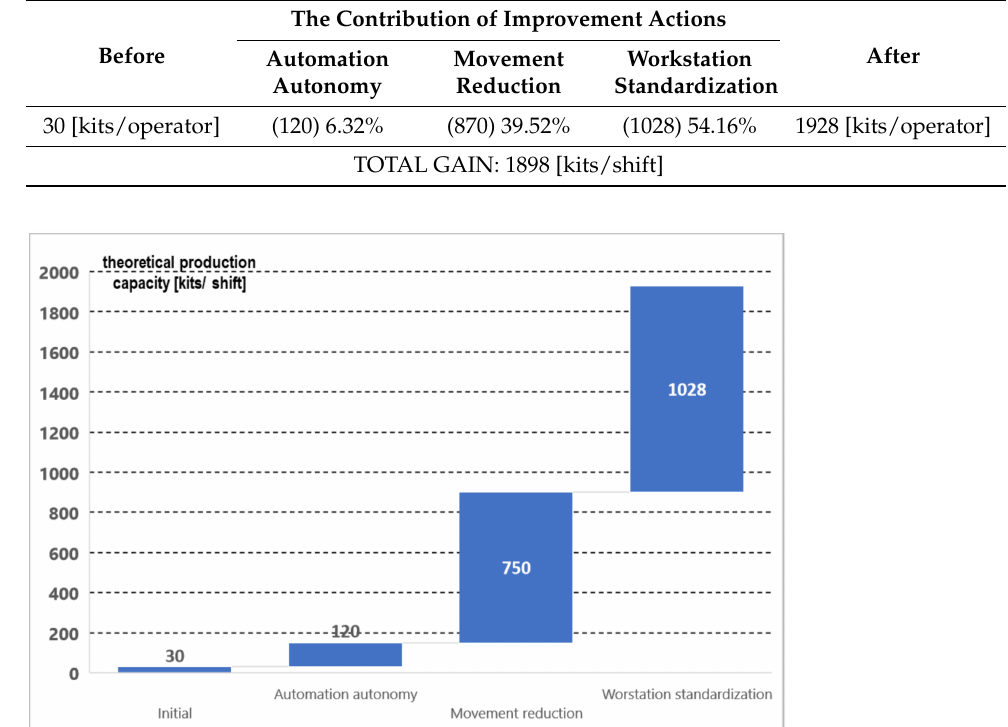
Figure 29. Evolution of production capacity depending on the improvement actions.